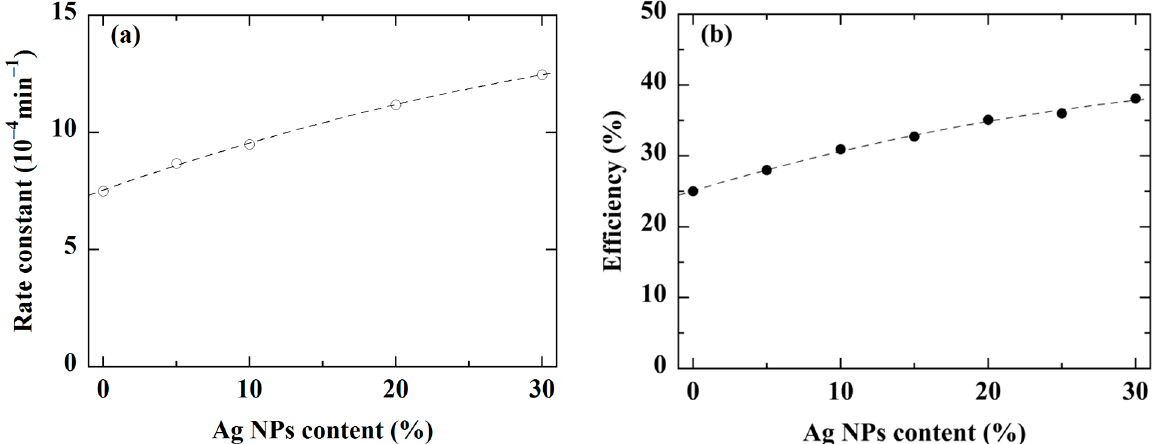
Figure 13. Rate constant ( a ) and photodegradation efficiency ( b ) of an IC solution after 6 h of illumination under halogen lamp irradiation equipped with a UV filter, with a ZnO thin film and a ZnO/Ag(NPs) thin film loaded at different Ag(NPs) contents. The curves are provided as guides for the eye.